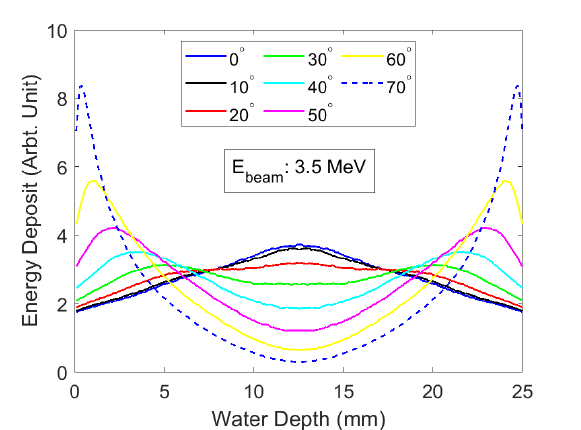
Figure 11. Depth-dose curves for a 3.5 MeV beam with a varying angle of